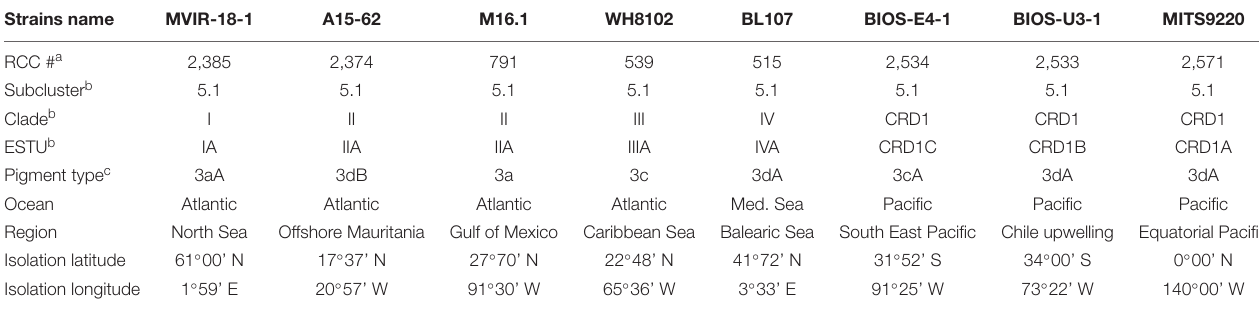
TABLE 1 | Characteristics of the Synechococcus strains used in this